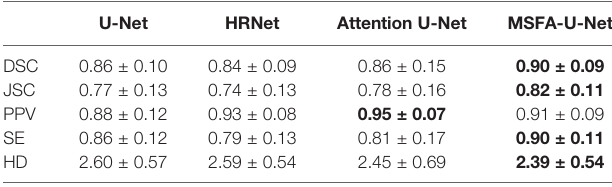
TABLE 2 | Assessment indices of the test set ( (cid:1) x ± s ).